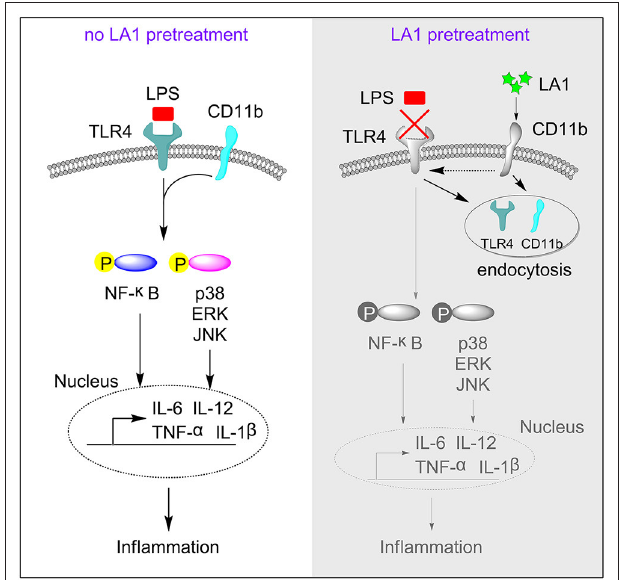
FIGURE 8 | The regulatory mechanism of LA1 on the activation of TLR4 pathway. This schematic shows that activation of CD11b by LA1 induces endocytosis of TLR4 and subsequently, to a certain degree, blocks the interaction of LPS with TLR4 which can decrease activation of TLR4 pathway and